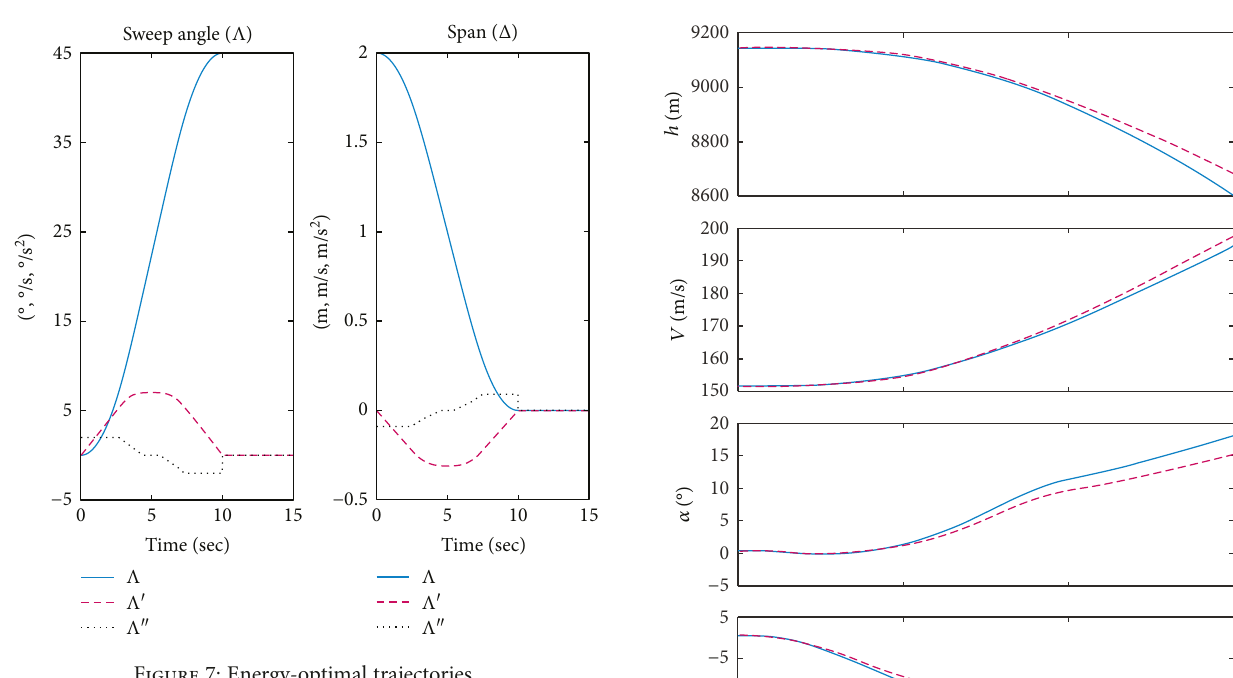
Figure 7: Energy-optimal